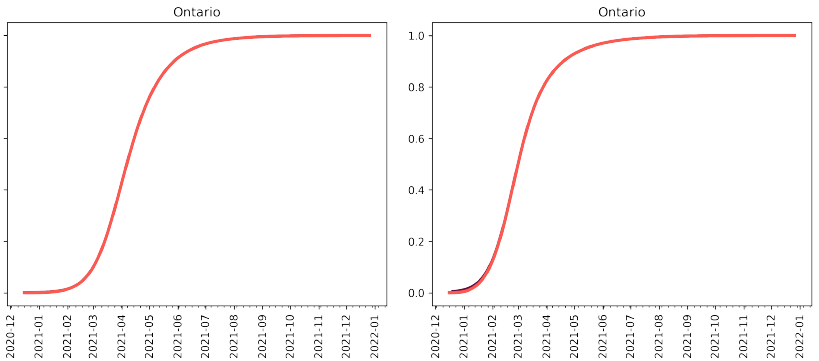
Figure 2. The proportion of active cases of the mutant strain. ( Left ) 60 active cases (100 cumulative cases) on 26 December 2020. ( Right ) 600 active cases (1000 cumulative cases) on 26 December